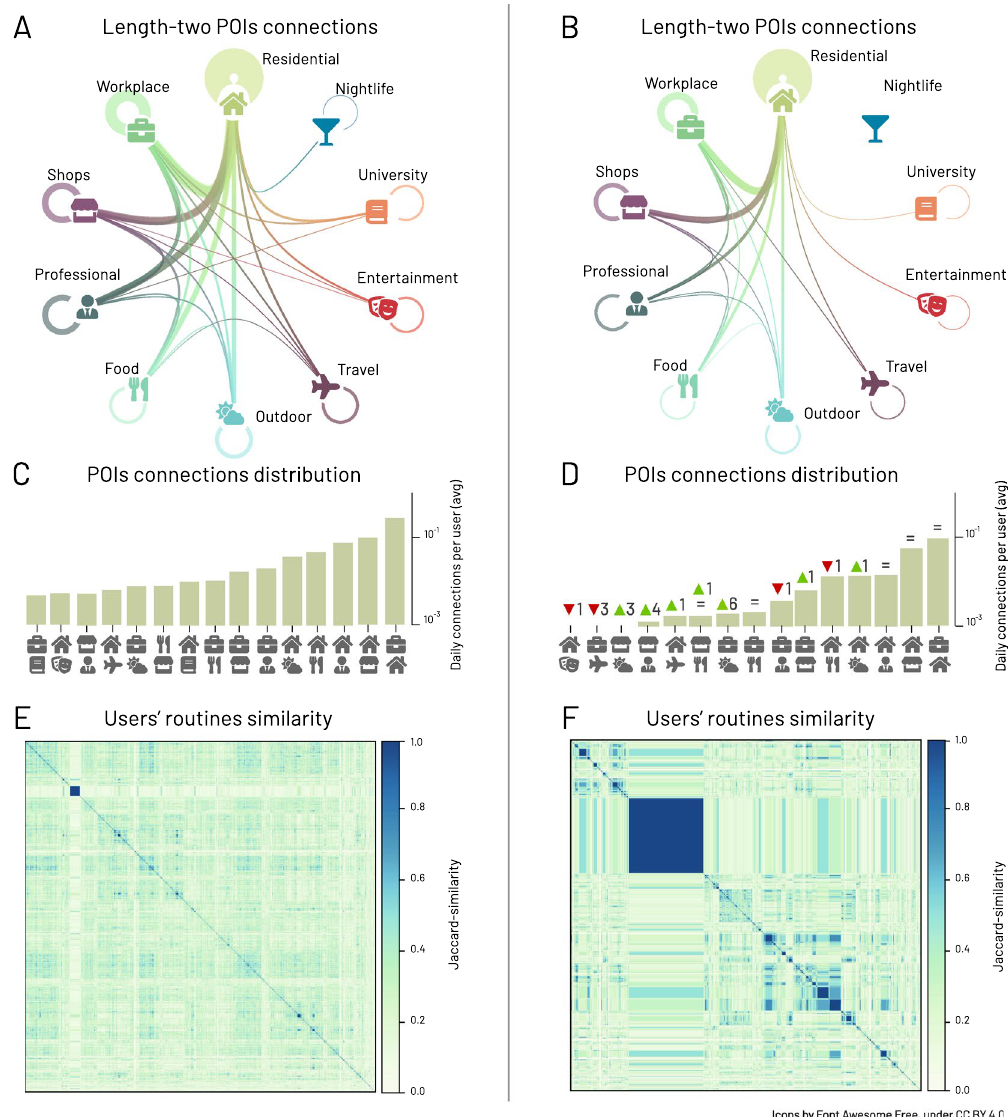
Figure 4. Changes in routine behaviour before and during the pandemic periods. ( A , B ) Network of the subsequent movements between POI categories for all users in the state of New York before and during the pandemic. The thickness of the links is proportional to the square root of the number of movements between the two POI categories. For visualization purposes we are showing only links for which the average number of daily movements is greater than 1 / 10 000 . Pre-pandemic ( C ) and during-pandemic ( D ) distributions of these intensities excluding self-loops (e.g., Residential ↔ Residential , Food ↔ Food connections). Jaccard similarity matrix between individuals’ routines before the pandemic ( E ) and during the pandemic ( F